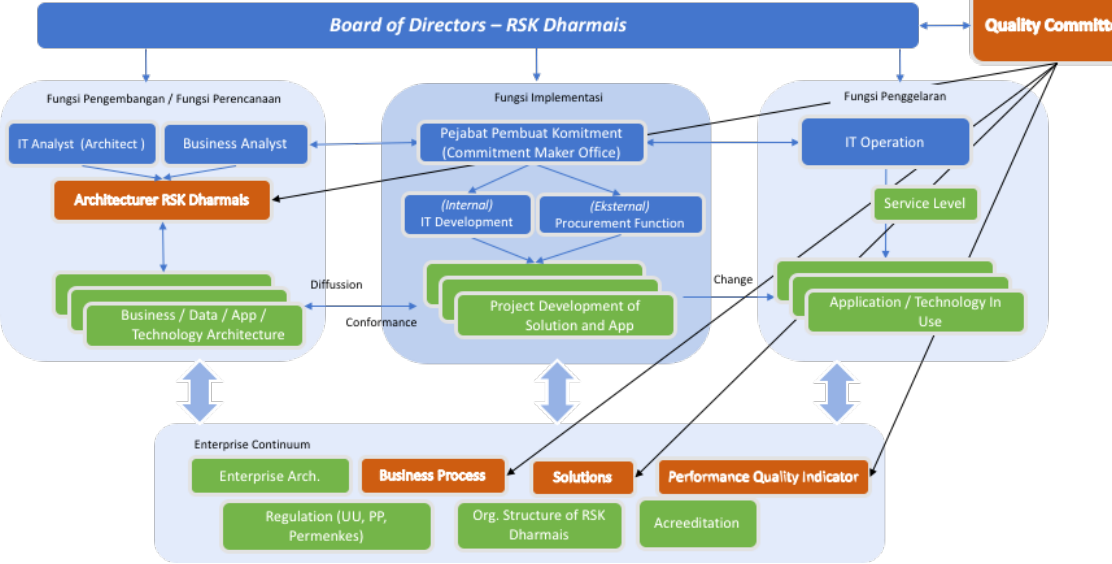
Figure 2. Proposed Architecture Governance